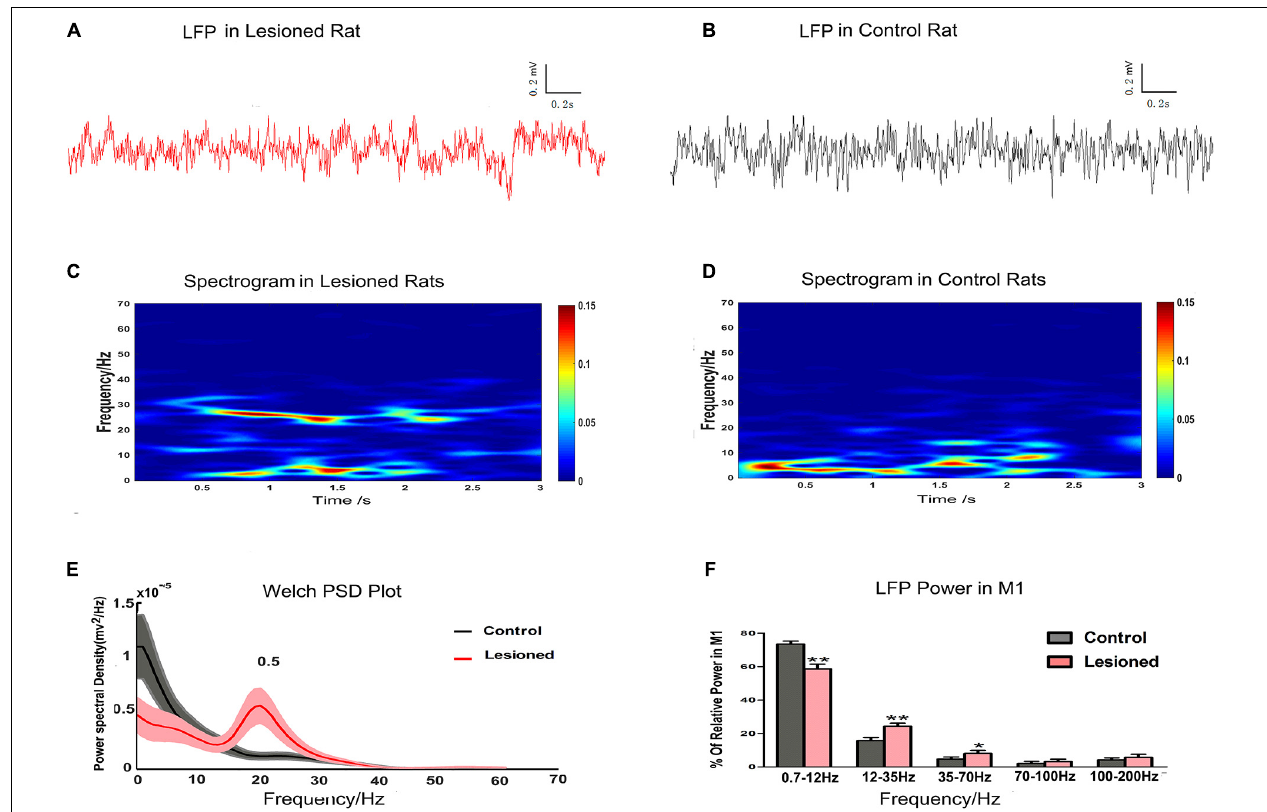
FIGURE 6 | Illustration of the impact of DA cell loss on LFP activities at resting. Representative examples of raw LFP recordings in M1 at rest from a DA neuron 6-OHDA-treated rat (plotted in red trace, A ) and control rat (plotted in black trace, B ). Mean spectrograms of LFP power in M1 of depletion rats ( n = 14 rats, C ) and control rats ( n = 13 rats, D ). Data were averaged across all sessions. The color scale is logarithmic with respect to greater spectral power illustrated in red color. The frequency distribution of the LFP calculated by Welch estimation were average over all sessions in control (black line) vs. depletion rats (red line) (E) . Bar graphs showed the mean relative LFP power from different frequency bands in the control (black bars) and the depletion rats (red bars), which significantly decreased at 0.7–12 Hz and significantly increased at 12–35 and 35–70 Hz in the 6-OHDA-treated rats compared with the control rats (F) . Error bars represent SEM, * indicates p < 0.05 and ** indicates p <